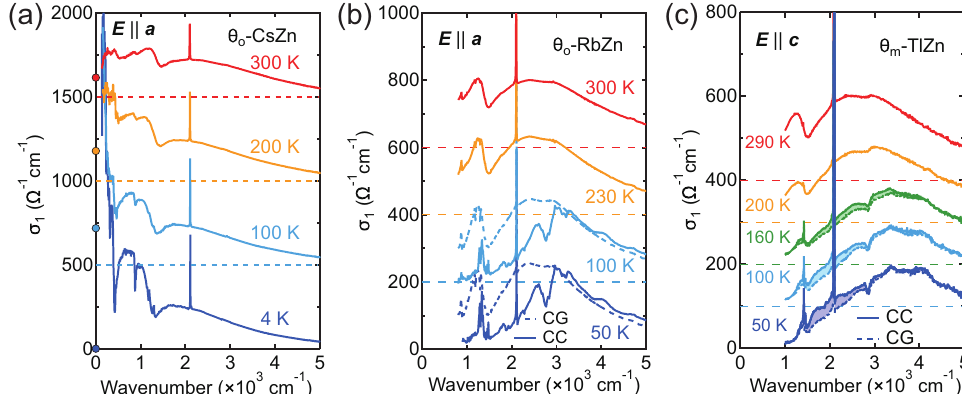
Figure 3. Optical conductivity spectra in the θ –type salts. ( a ) Optical conductivity spectra σ 1 ( ω ) in θ o -CsZn measured at several temperatures during slow cooling of 1K/min. ( b ) Optical conductivity spectra σ 1 ( ω ) in θ o -RbZn measured at several temperatures during slow cooling of 1K/min (solid line) and slow heating after rapid cooling of more than 50K/min when passing through T CO (dashed line). ( c ) Optical conductivity spectra σ 1 ( ω ) in θ m -TlZn measured at several temperatures during slow cooling of 1K/min (solid line) and slow heating after rapid cooling of more than 50K/min when passing through T CO (dashed line). For clarity, the data are shifted vertically. Note that the sharp peak at approximately 2100cm − 1 is the CN stretching mode of SCN in the anion